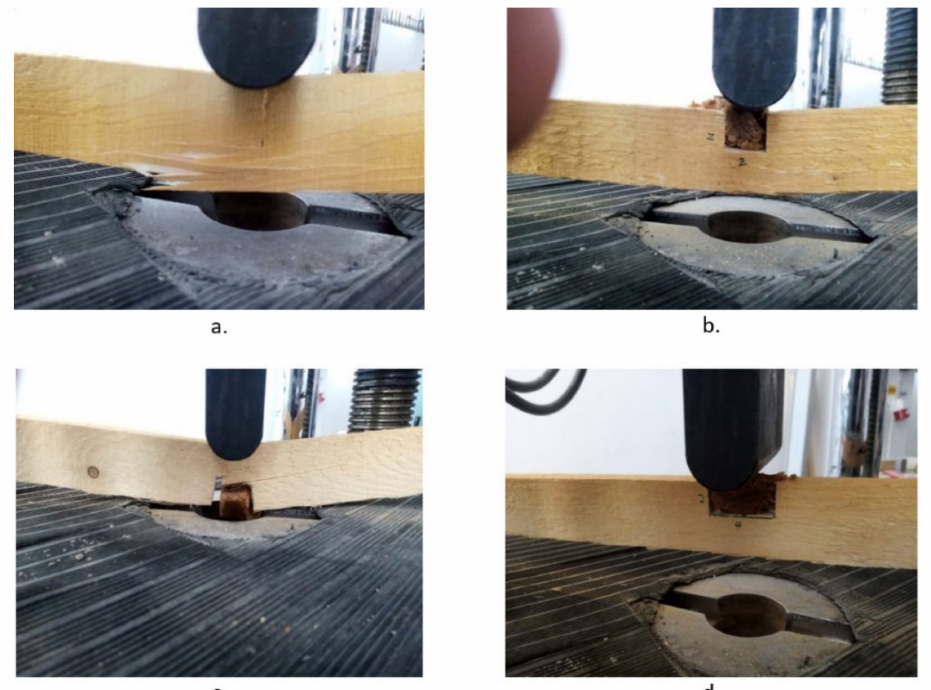
Figure 6. Failure modes of plain and “liquid wood” retrofitted wooden beams: ( a ) bending failure of the plain wooden beam; ( b ) failure in bending by compression of retrofitted 2 × 2 groove beam; ( c ) failure in bending by tension of retrofitted 2 × 4 groove beam; ( d ) cell load and deflection in bending by compression of retrofitted 2 × 4 groove beam.